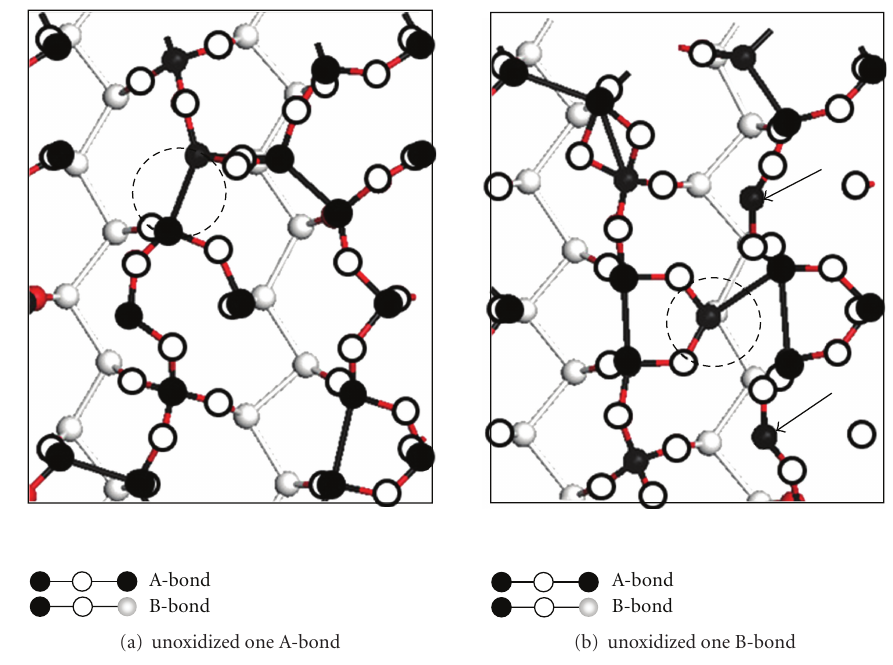
Figure 5: Top views of obtained atomic configurations of cells including (a) unoxidized one A-bond and (b) unoxidized one B-bond. Black (white) balls indicate the Si atoms in the first (second) layer. The dotted circles indicate the unoxidized bonds. The Si atoms indicated by arrows in (b) moved outward at a large